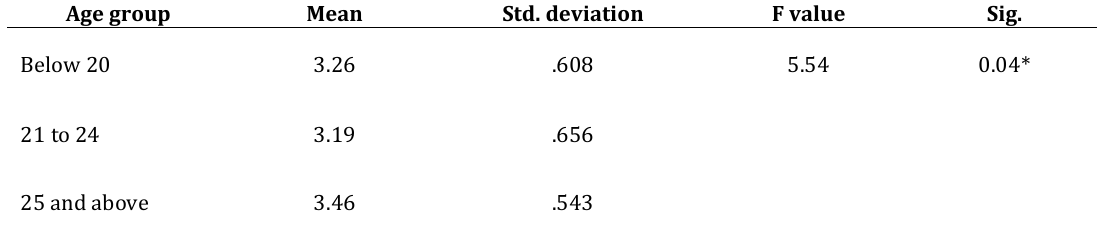
Table 3.The differences between age group and awareness of Shariah-based PRS Age group Mean Std. deviation F value